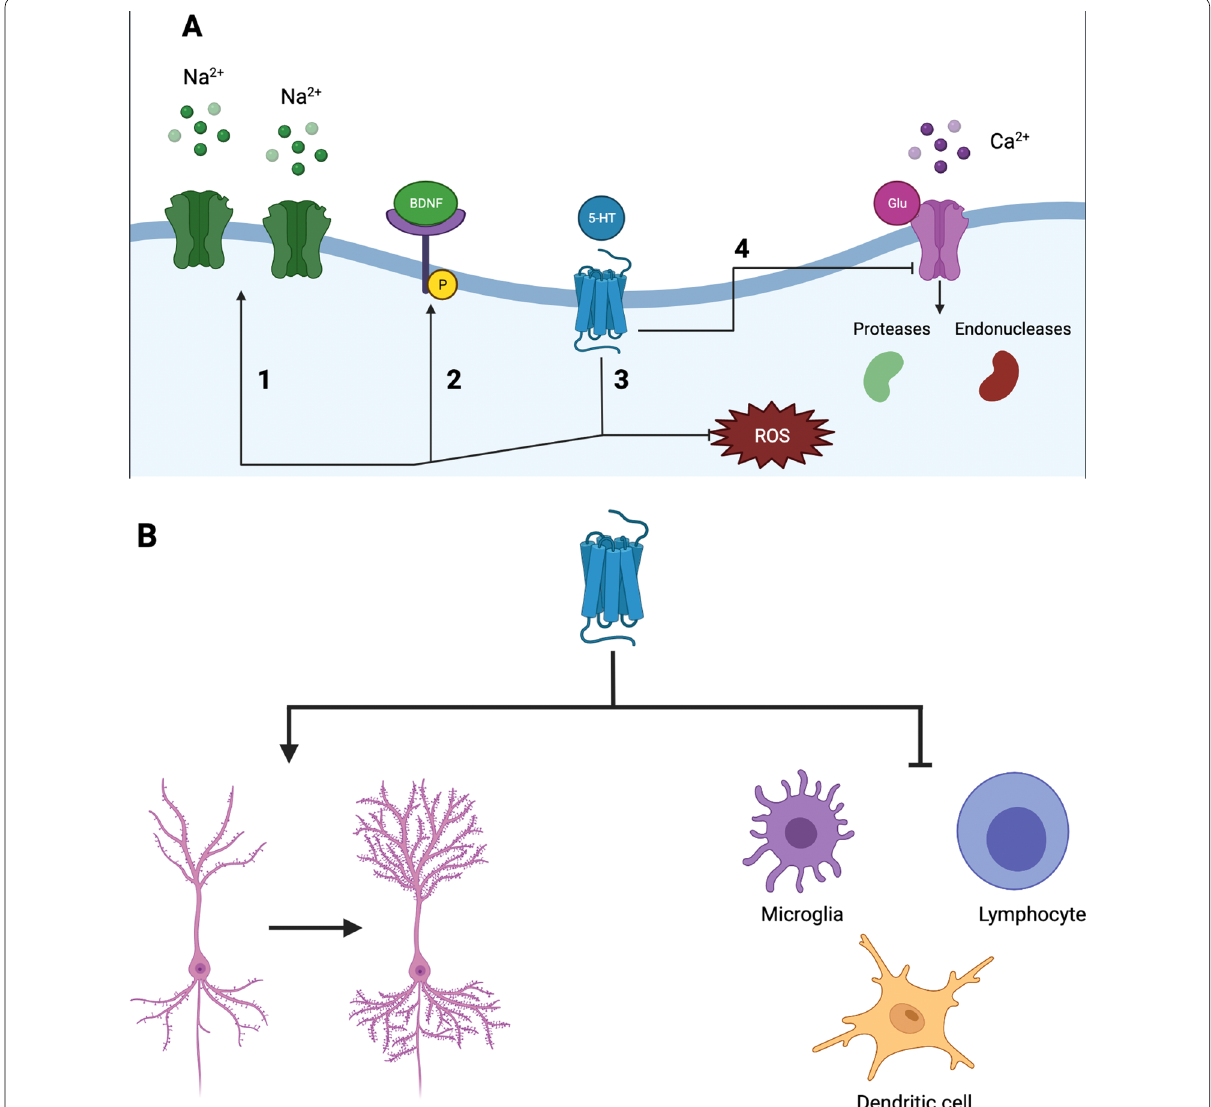
Fig. 2 Cellular and molecular effects of 5‑HT 7 receptors. Molecular effects of 5‑HT 7 activation. A When activated, 5‑HT7 receptors modulate ion transmission through enhancing LTP and LTD (1); these receptors also increase the number of neurotrophins (especially BDNF) and the affinity of its receptor Trkb (2); through ERK and Akt, 5‑HT 7 decreases neuronal damage mediated by ROS (3); and reduces the excitotoxicity burden mediated by glutamate‑NMDA‑calcium. Cellular effects of